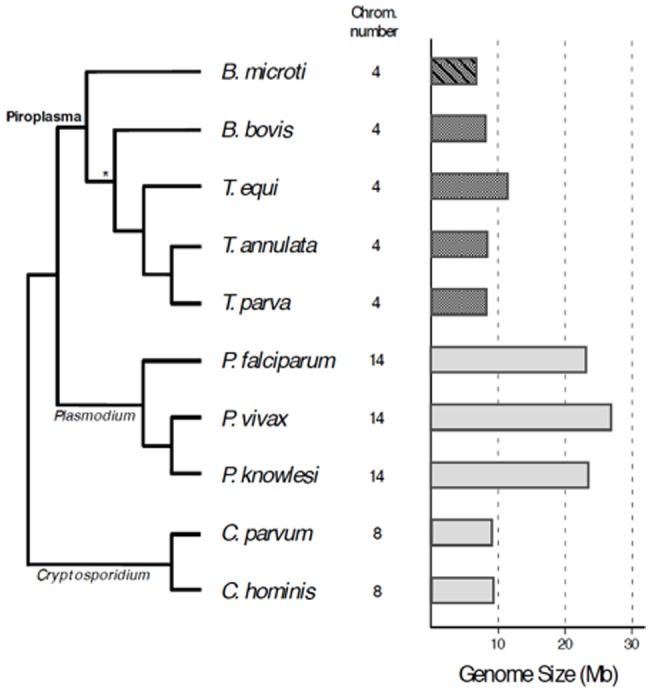
Genome size and chromosome number in apicomplexan species.Number of nuclear chromosomes and genome size are shown in panel on the right. Piroplasma taxa shown in dark color; B. microti stripped. Schematic of phylogenetic relationships among species shown on the left. Resolution of the interior node in the piroplasma clade marked with ‘*’ resolved according to [34], based on study with 150 nuclear genes. Resolution differs from that obtained with mitochondrial sequences (Fig. 8) and the 18S rDNA gene [6].